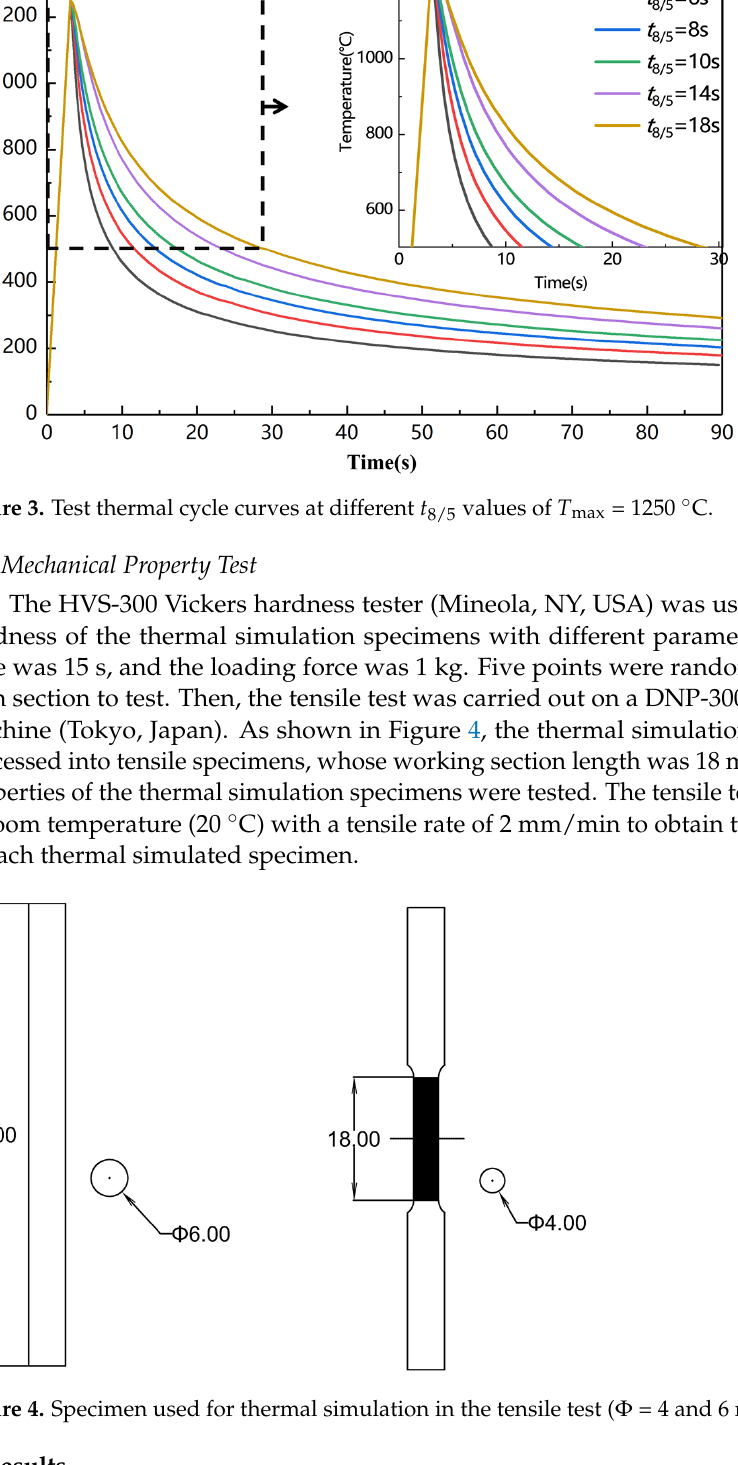
Figure 3. Test thermal cycle curves at different t 8/5 values of T max = 1250 °C.